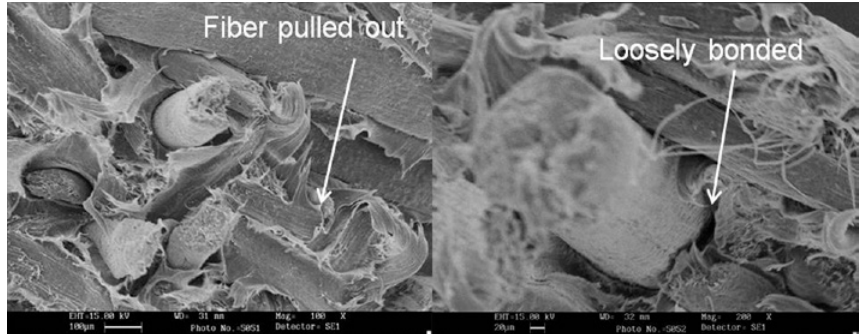
Figure 8: SEM micrograph of the tensile fracture surface of sample S5 at × 100 and × 200